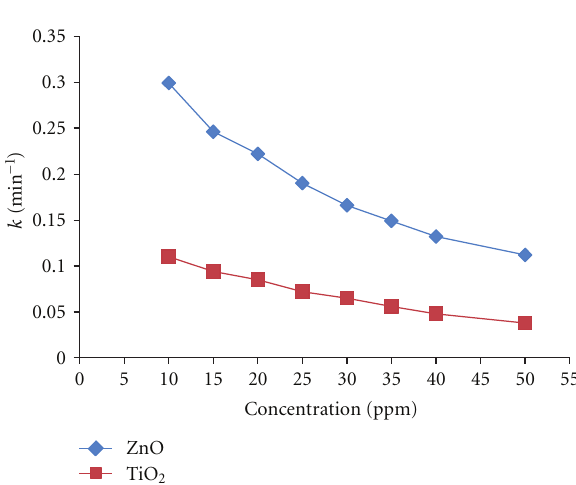
Figure 3: E ff ect of initial dye concentration on rate constant. Figure 4: E ff ect of initial pH of solution on rate constant.